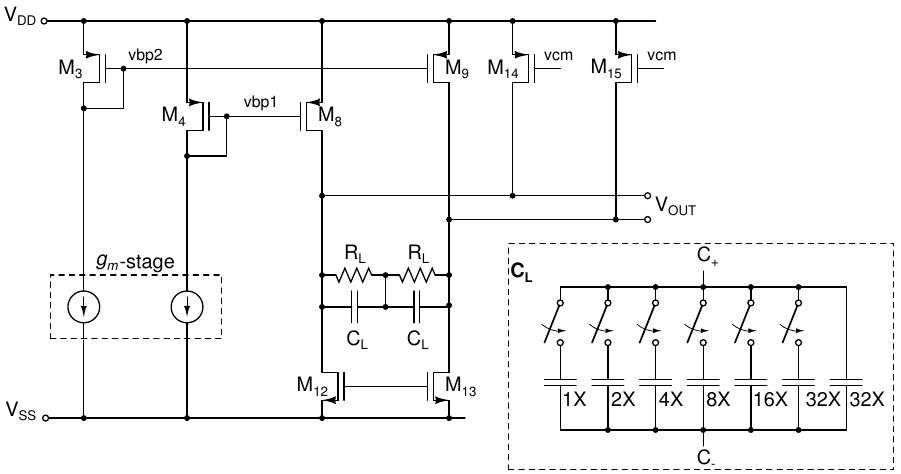
Figure 10. Schematic of the BW-limited TIA stage of the